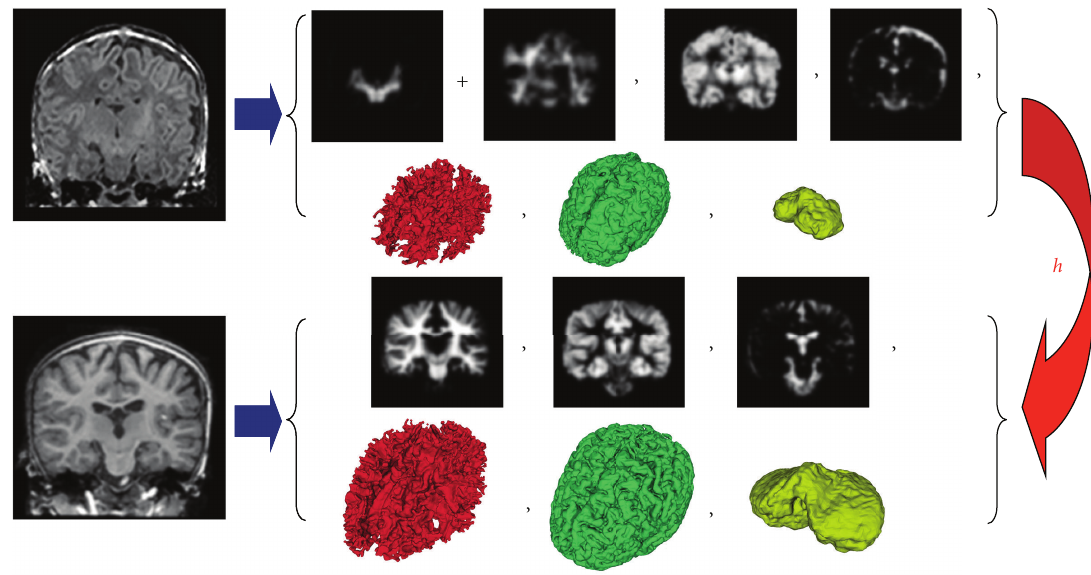
Figure 2: Overview of the proposed registration method that can handle large deformations and di ff erent contrast properties, applied to mapping brain MRI of neonates to 2-year olds. We segment the brain MRIs and then extract equivalent anatomical descriptors by merging the two di ff erent white matter types present in neonates. The probabilistic and geometric anatomical descriptors are then used to compute the transformation h that minimizes the distance between the class posterior images, as well as the distance between surfaces represented as